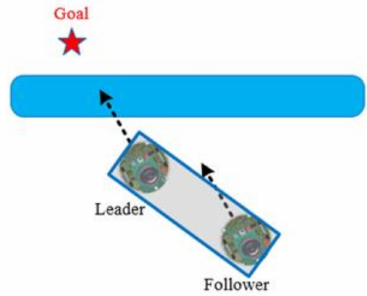
Figure 18. Leader detects the